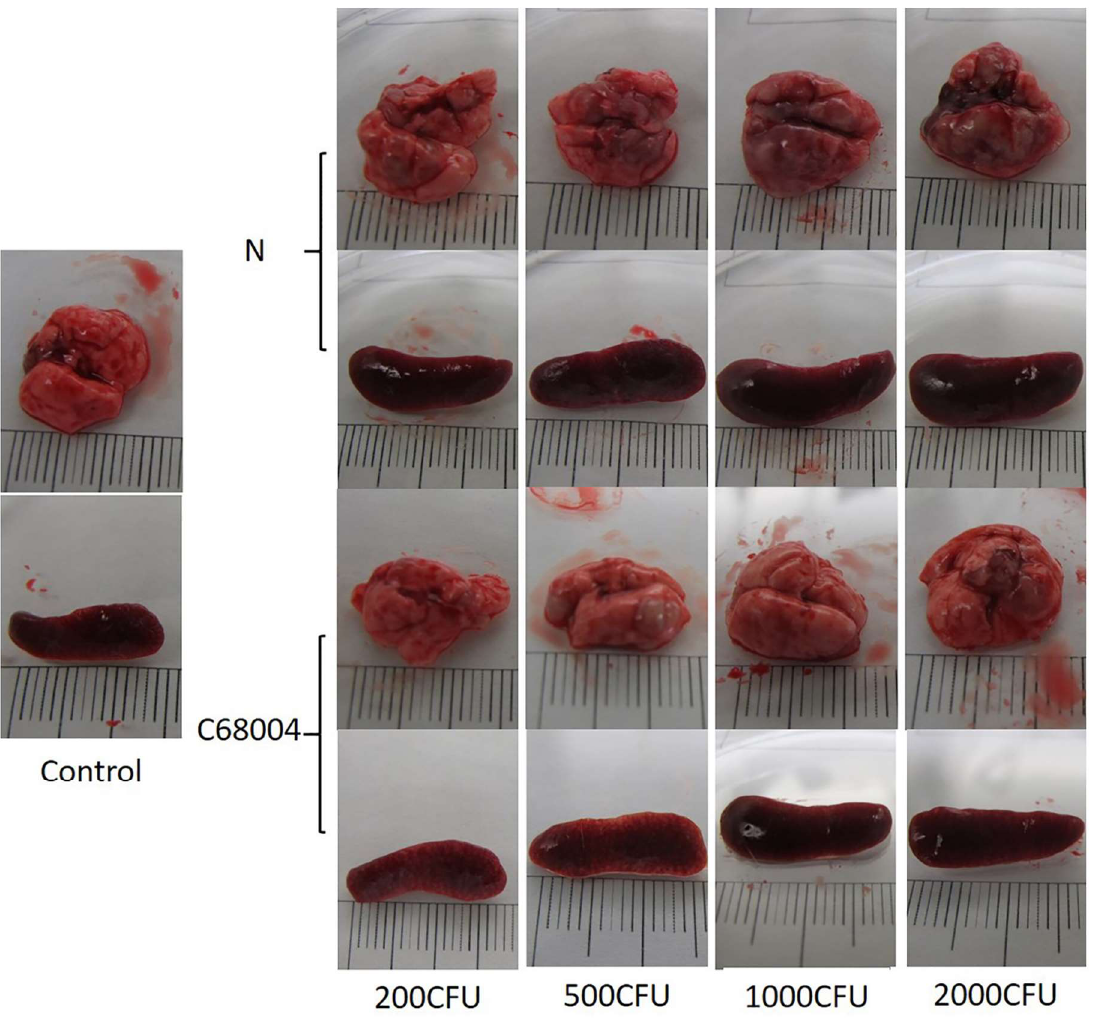
Figure 1. Representative photographs showing gross lesions of the lung and spleen of mice infected with different strains of Mycobacterium bovis . The lung and spleen were aseptically removed from the mice at the end of the clinical observation (30 days post-inoculation) before death. Pictures of the lung and spleen of mice infected with 200, 500, 1000, and 2000 colony-forming unit (CFU) of M. bovis N and M. bovis C68004 strains are shown individually. Control shows the lung of the mice inoculated with phosphate buffer saline (PBS).